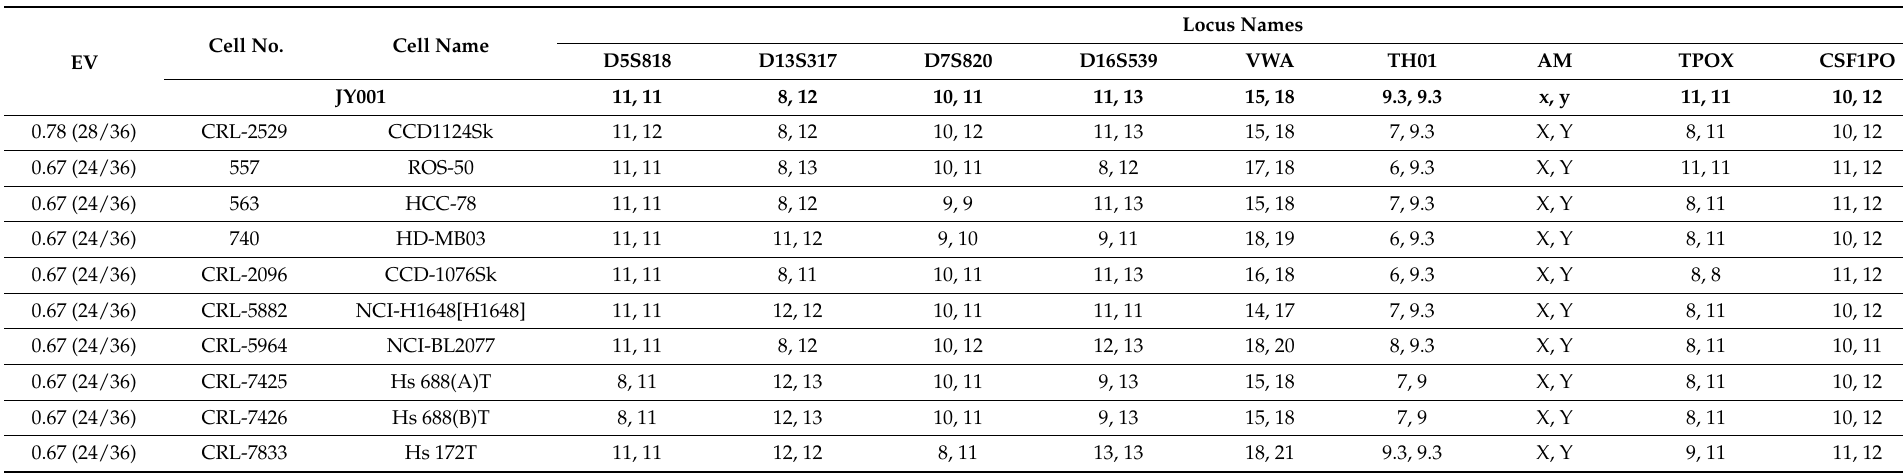
Table 1. Short tandem repeat profiling of JY001.